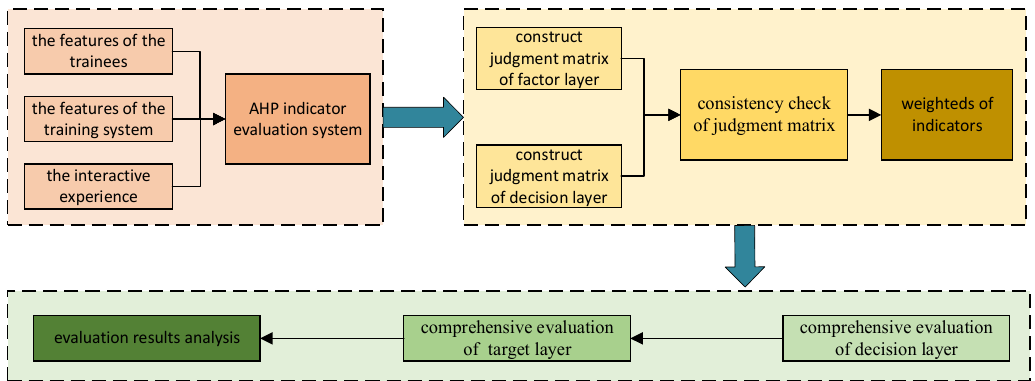
Figure 5. The specific comprehensive evaluation process.